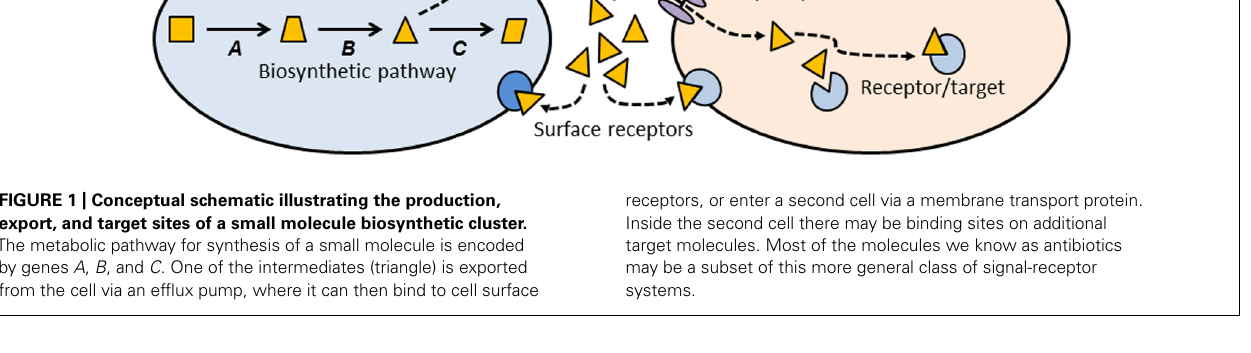
receptors, or enter a second cell via a membrane transport protein. Inside the second cell there may be binding sites on additional target molecules. Most of the molecules we know as antibiotics may be a subset of this more general class of signal-receptor